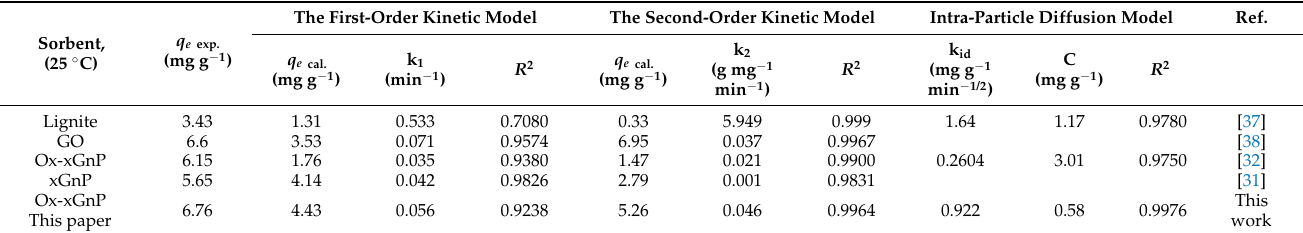
Table 3. Pseudo-first-order and pseudo-second-order kinetic models for the removal of NH 4+ . q e exp. Sorbent, (mg g − 1 (25 ◦ C)